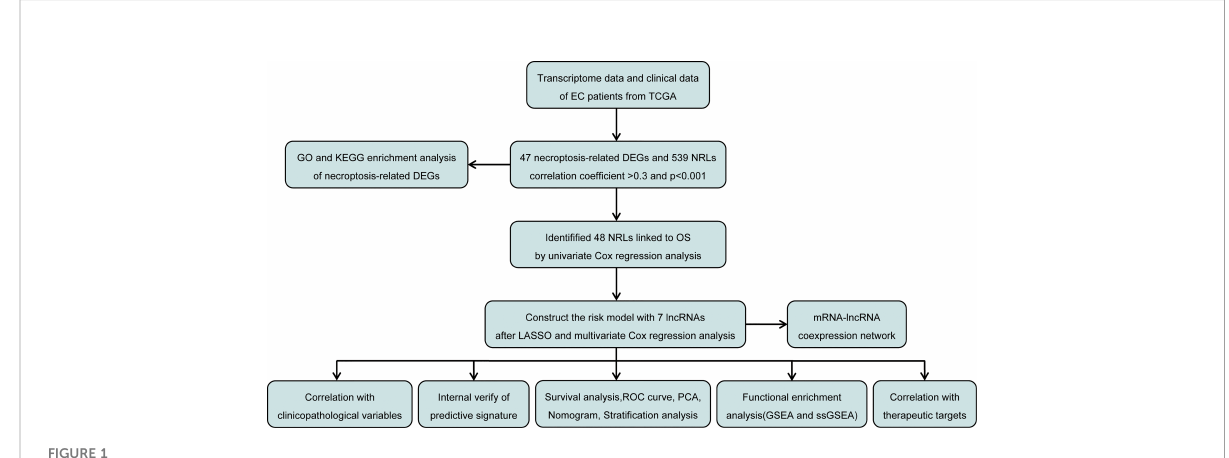
FIGURE 1 Flow diagram of the study